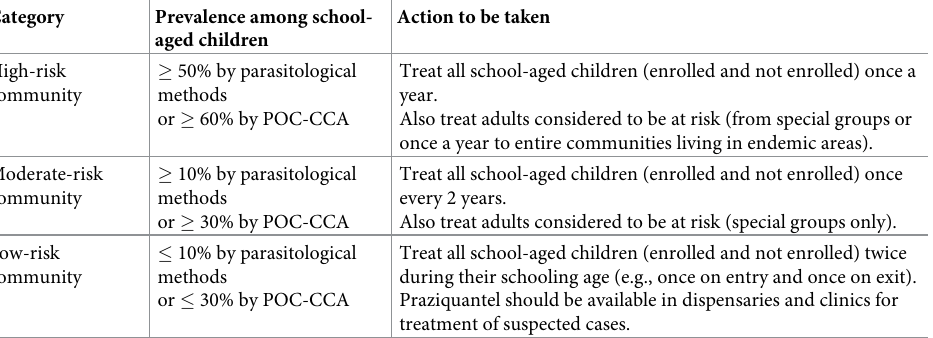
Table 6. WHO recommended treatment strategy for schistosomiasis mansoni [8] extended with the suggested thresholds for POC-CCA from Table 5. Category Prevalence among school- aged children